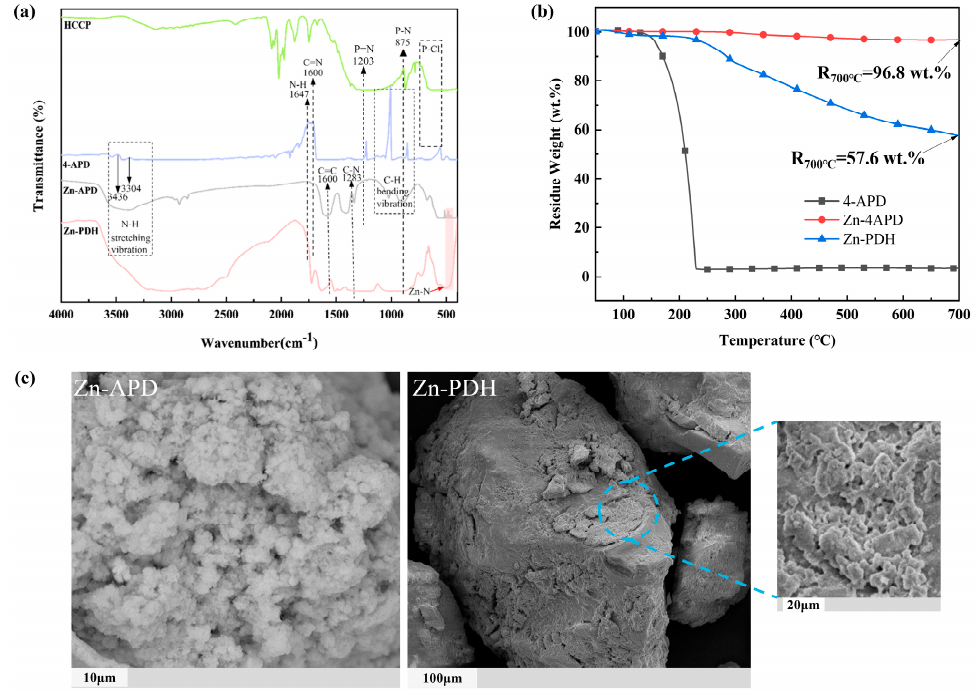
Figure 1. FTIR of flame retardants ( a ), the TGA curves of intermediate and final products ( b ), and SEM photos of the Zn − APD and Zn − 4APD ( c ). Table 1. EDS data for organometallic complexes.